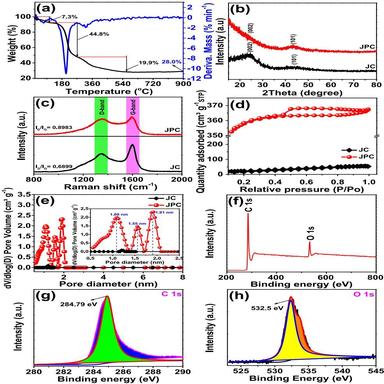
(a) TGA plot of Jujube fruit powder; (b) XRD spectra, (c) Raman spectra, (d) Nitrogen adsorption–desorption isotherms and (e) pore-size distributions of JC and JPC materials; (f-h) XPS spectra of JPC: (f) full survey spectrum, high resolution XPS spectra of (g) C 1 s and (h) O 1 s.